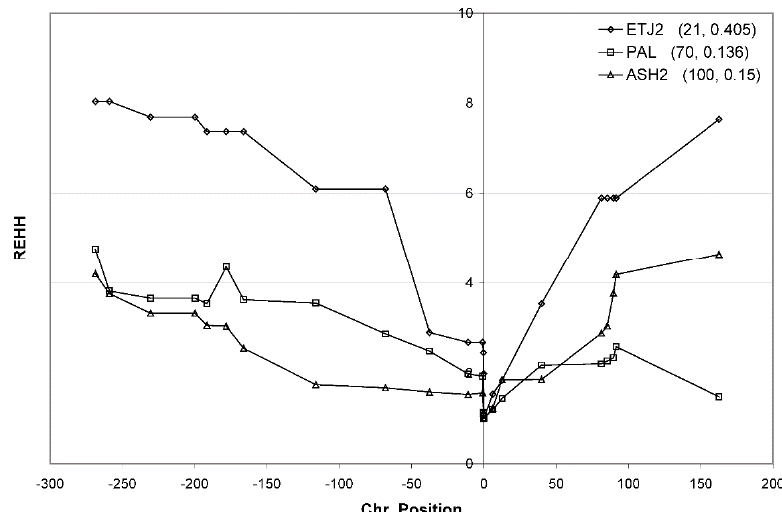
Figure 8. The REHH of three new confirmatory populations, Ethiopian Jews (ETJ2), Ashkenazi (ASH2), and Palestinian Arabs (PAL). At lower SNP density but approximately similar distance from the core, all populations show REHH increases over distance.